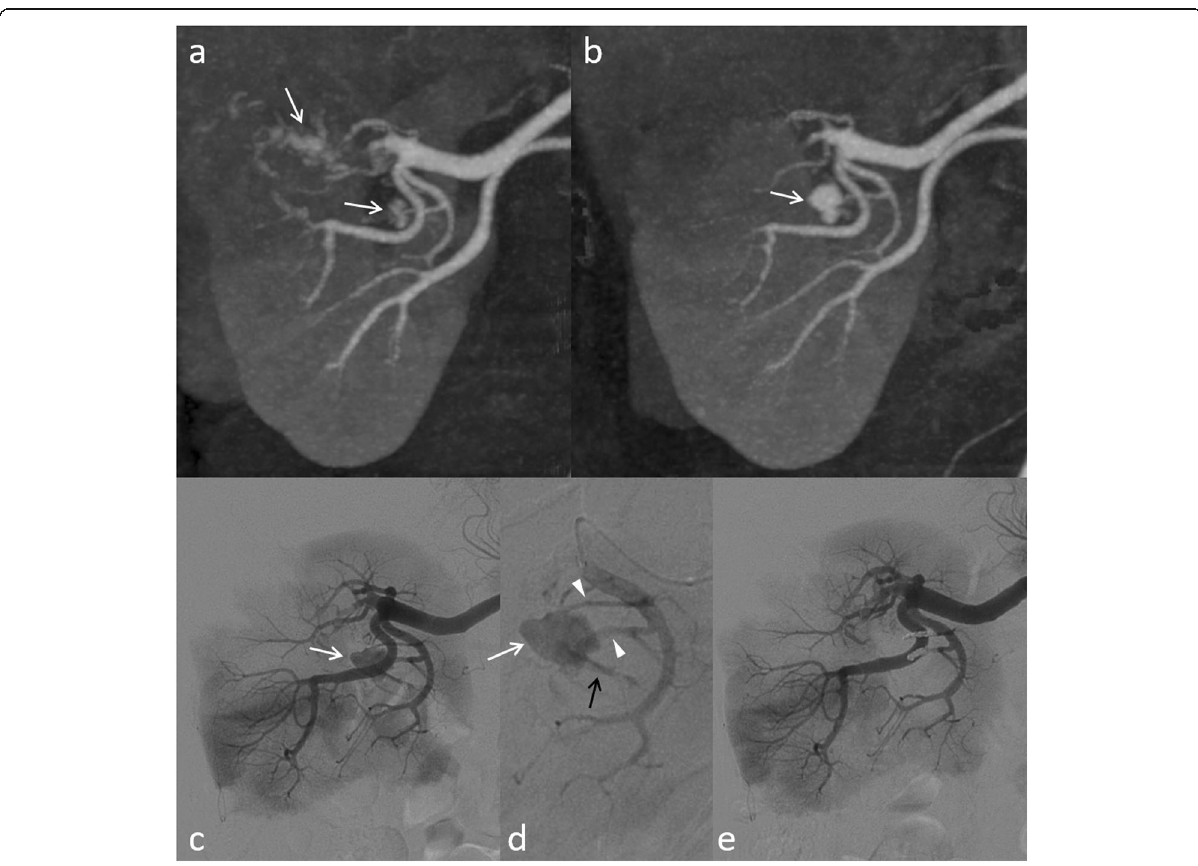
Fig. 4 A case of a developing renal artery pseudoaneurysm (RAP), with symptoms, in a 54-year-old woman. a Irregularly shaped enhancements are observed (arrows) on early postoperative contrast-enhanced CT on postoperative day (POD) three. b The larger one disappeared and the smaller one increased in size developing into RAP (arrow) on CT on POD seven, with sudden hematuria. c , d , e Angiography shows two branches (arrowheads) that feed the RAP (white arrows) with extravasation into the renal pelvis (black arrow), which are successfully embolized using microcoils on POD